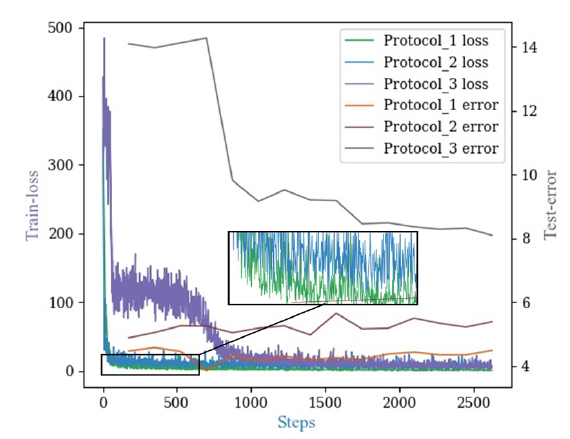
Figure 7. Training loss and testing mean error of the different protocols.